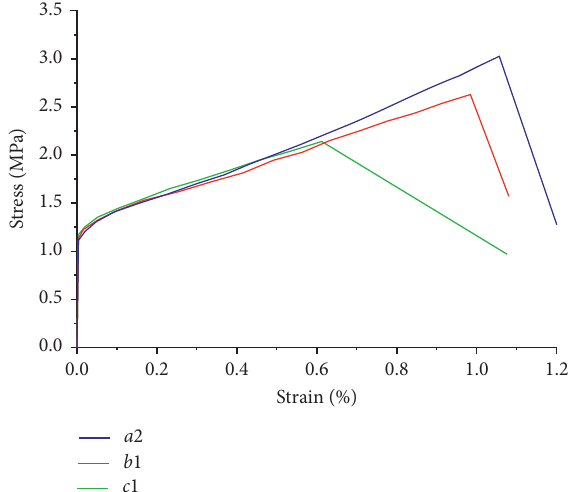
Figure 5: Stress-strain curves of rock samples on different moisture conditions during Brazilian splitting